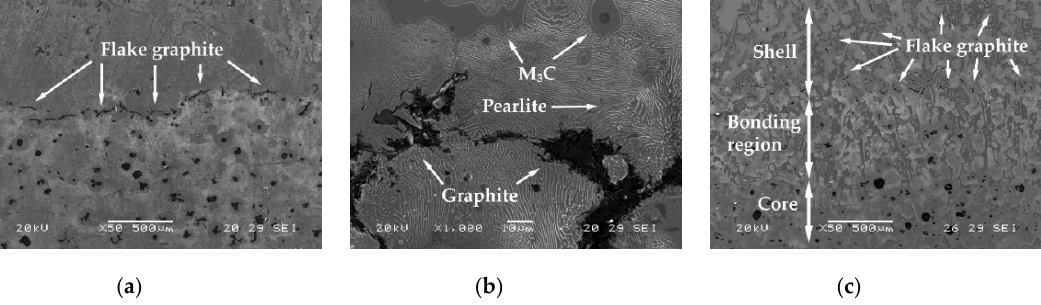
Figure 3. Flake graphite located in the region of the shell adjacent to the bond interface. This mainly appears in those experiments in which the shell was inoculated with FeSi-La, ( a ) Bonding region corresponding to experiment 2. Micrograph obtained by scanning electron microscopy. ×50 magnifications, ( b ) Bonding region corresponding to experiment 2. In addition to the presence of flake graphite, the presence of eutectic M 3 C carbides and austenite fully transformed into pearlite can also be observed. Micrograph obtained by scanning electron microscopy. ×1000 magnifications, ( c ) Bonding region corresponding to experiment 4. Micrograph obtained by scanning electron microscopy. ×500 magnifications.